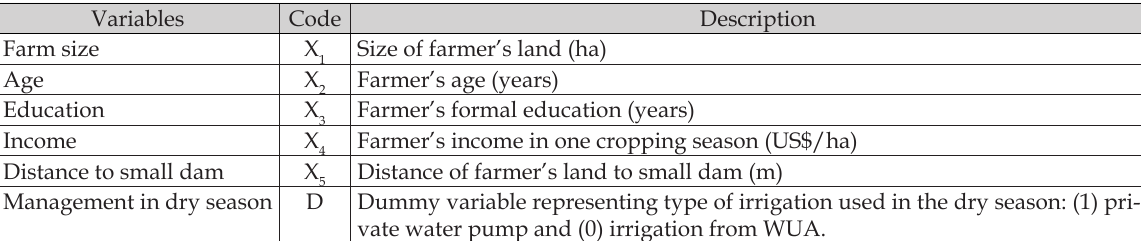
Table 1. variables in the